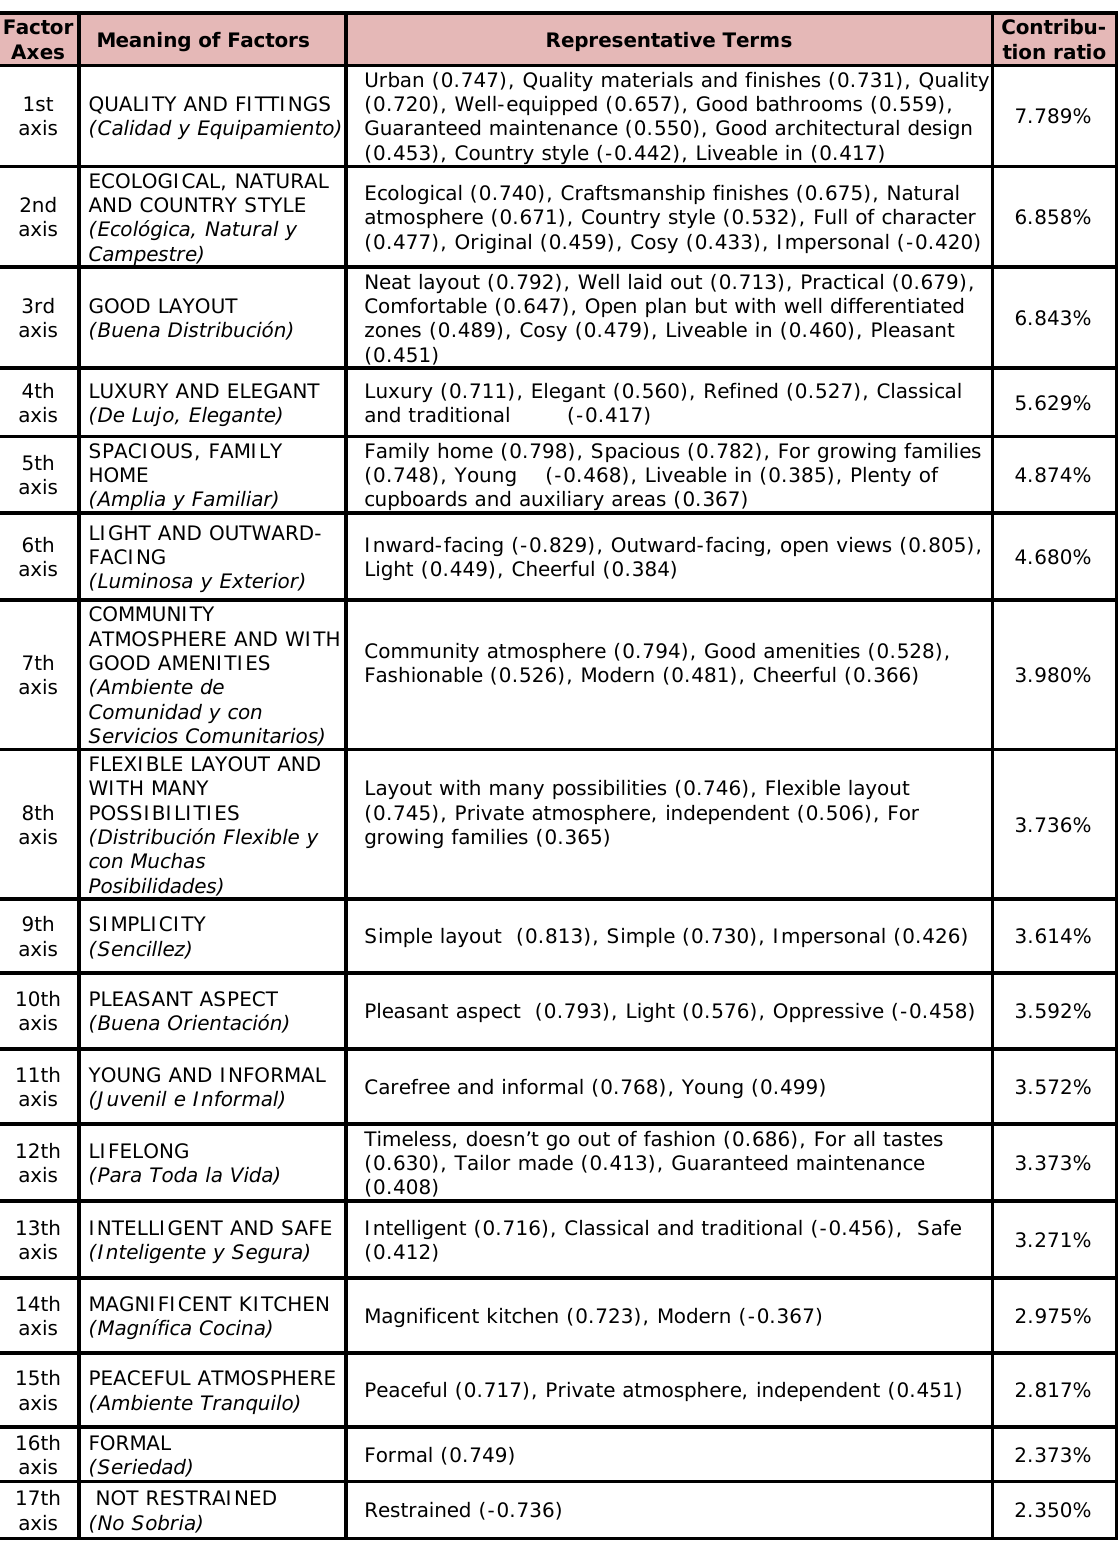
Table 5. “Range of meaning of semantic axes and representative terms-Women (In brackets, original Spanish words)”. Source: